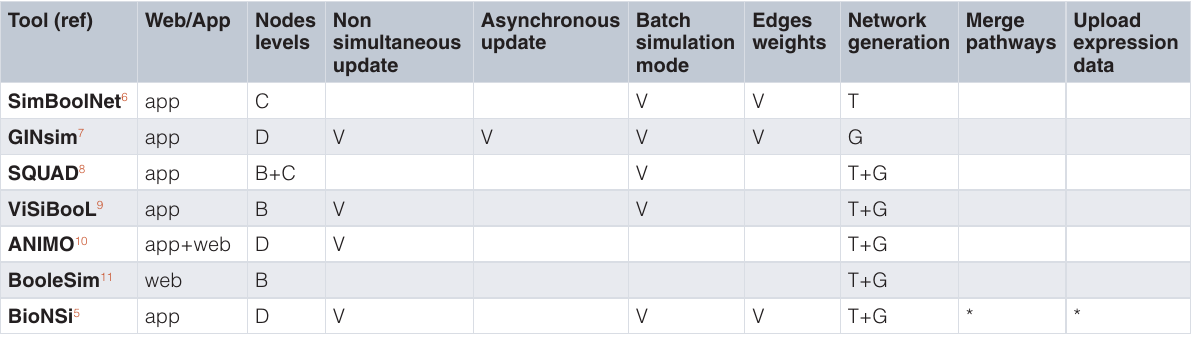
Table 1. A representative list of free, network simulation, tools for non-programming biologists. A representative list of seven network simulation tools was obtained from OmicsTools. A summary of some important features is shown. V: denotes that a specific feature exists in the tool. Web/App: a web tool or downloadable software. Nodes levels: Boolean (B)/discrete (D)/continuous (C). Non-simultaneous update: defining delays on edges or priorities on nodes, which inflict order on the update of nodes. Asynchronous update: non-deterministic behavior which enables several successors to a single network state. Batch simulation mode: running a collection of simulation with various parameters to reveal emergent network properties. Edges weights: weights represent strength of interaction. Network generation: textual (T)/graphical (G). A star (*) represents features implemented in the extended BioNSi tool (but not in the original